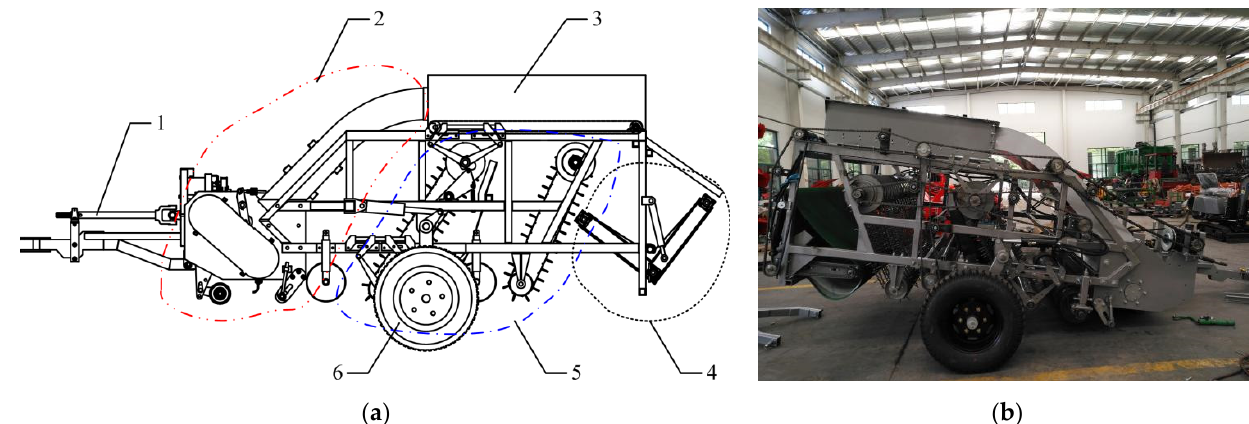
Figure 1. Structure diagram of the 4JMLE-210 agricultural residual film recycling machine. 1. Drive shaft 2. Straw-crushing and throwing unit 3. Straw-conveying unit 4. Residual film winding-up unit 5. Residual film picking-up unit 6. Hydraulic drive the walking wheels. ( a ) Structure diagram. ( b ) Picture of real products.